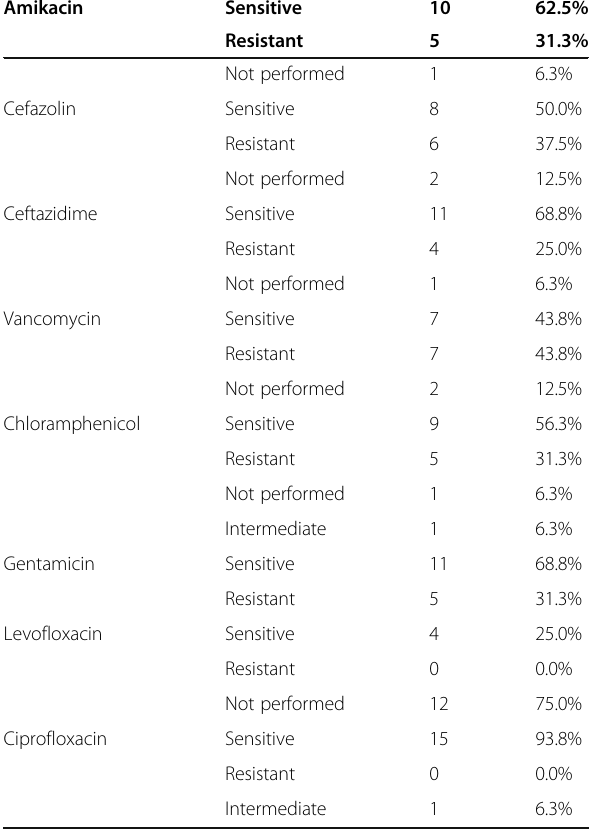
Table 4 Sensitivity tests for different usual antibiotics